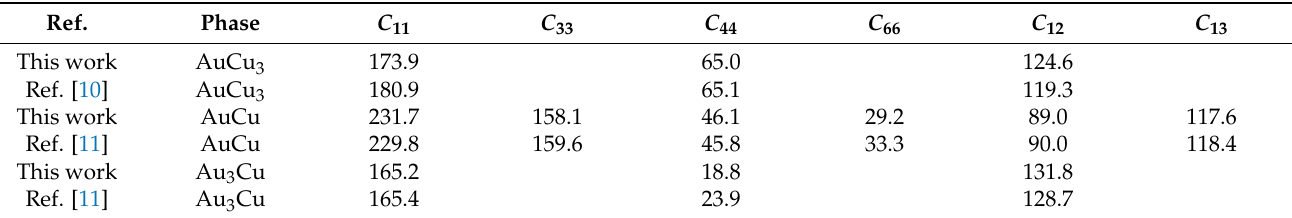
Table 2. Calculated elastic constants of Au–Cu IMCs